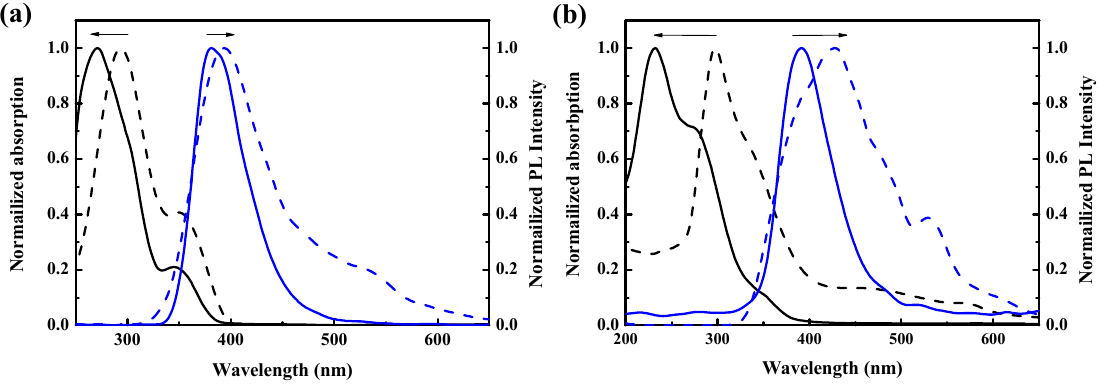
Figure 1. Absorption and photoluminescence spectra of ( a ) PCaT and ( b ) PCT in THF solution (solid line) and in thin film (dotted line). Table 2. Optical properties of